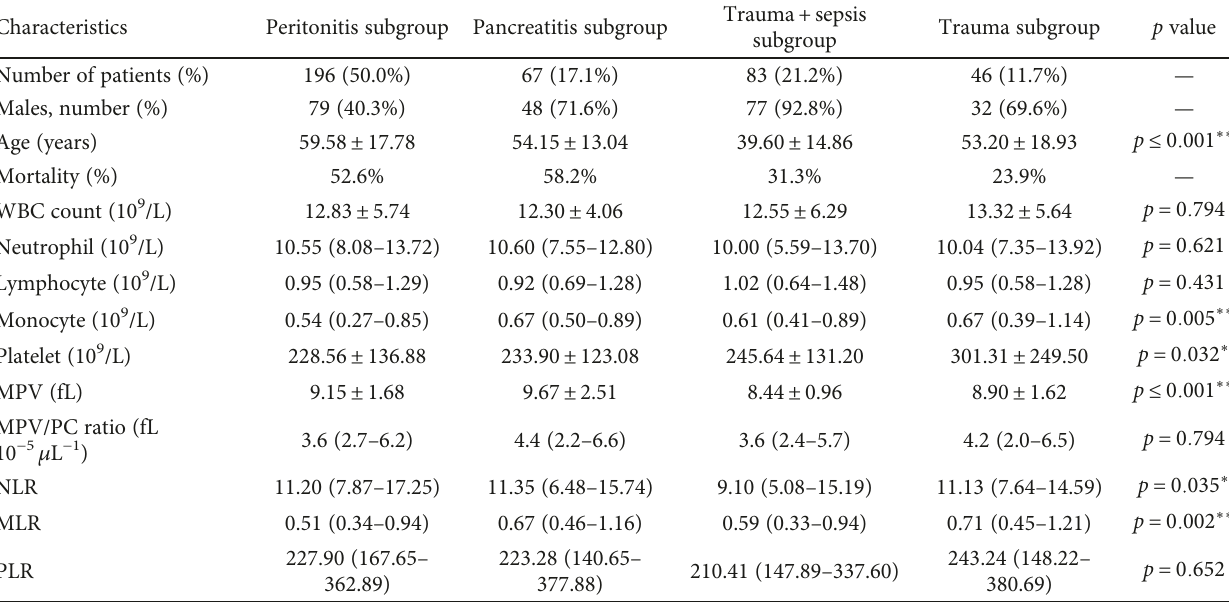
Table 4: Baseline and laboratory characteristics of all patients according to underlying